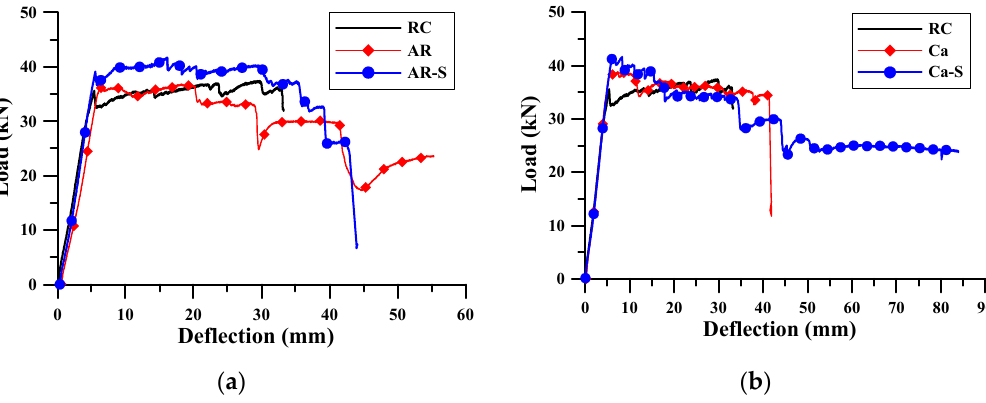
Figure 6. Load and deflection curves until failure: ( a ) AR-glass TRM beam; ( b ) Carbon TRM beam. Table 3. Post-cyclic monotonic loading results.